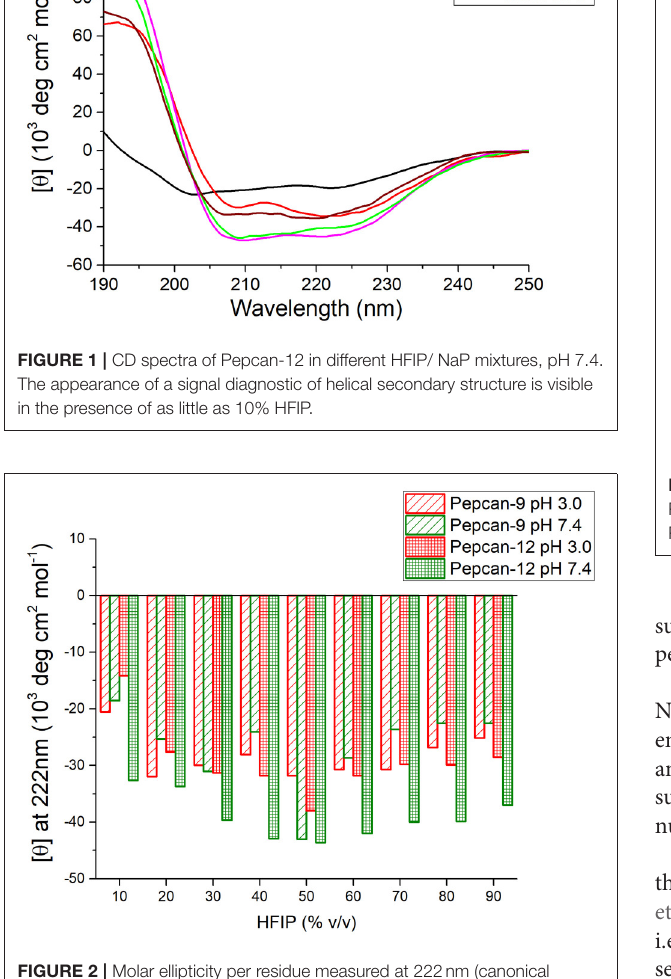
FIGURE 2 | Molar ellipticity per residue measured at 222nm (canonical minimum of α -helix conformation) as function of HFIP content in the mixture, for all conditions studied.